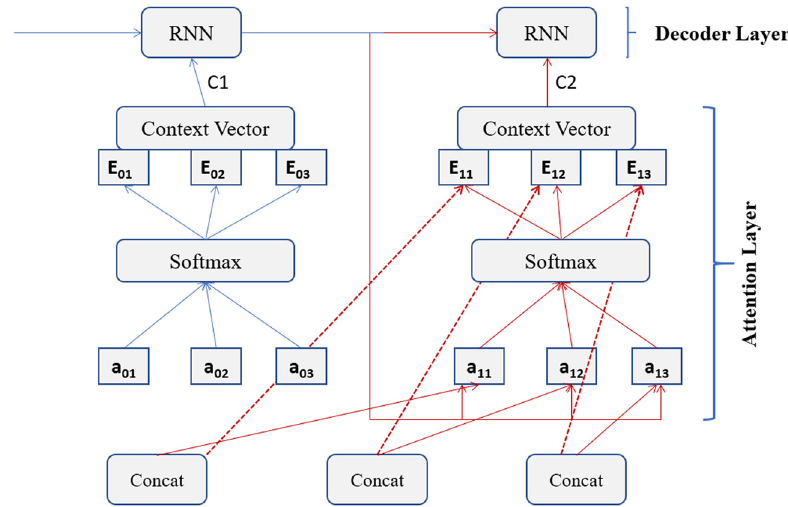
Figure 10: Decoder and attention layer.